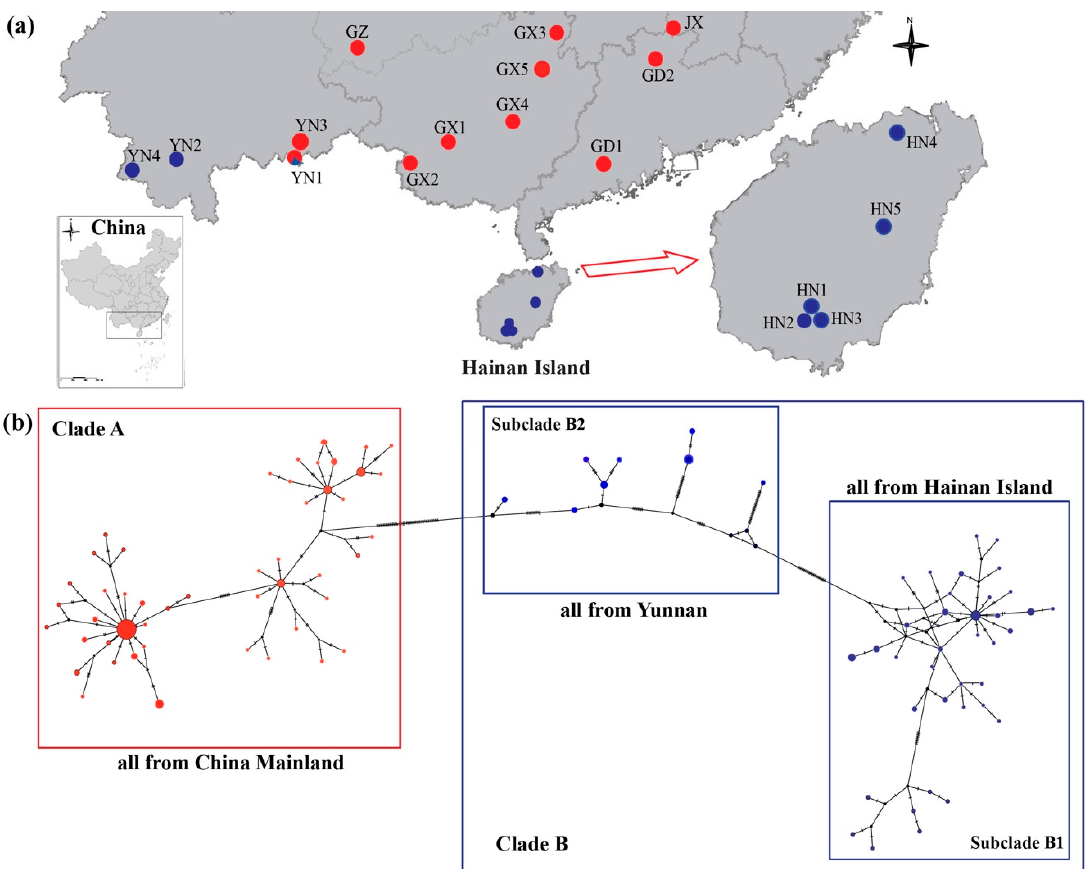
Figure 1. Sampling sites ( a ) and mitochondrial DNA nested haplotype clade ( b ) for Hipposideros larvatus in China.